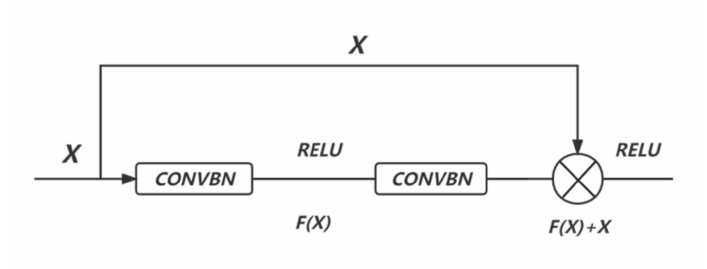
Figure 3. Residual Learning Module.